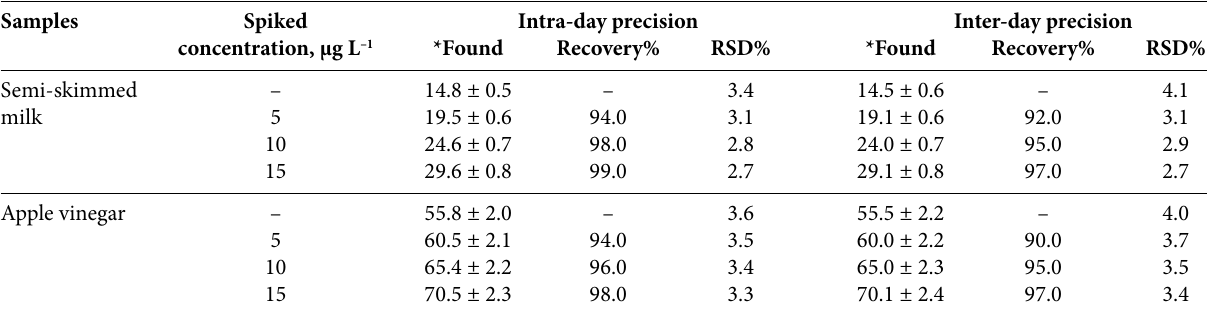
Table 3. (b) The reproducibility and repeatability for the replicate measurements of total V in quality control samples spiked with 5, 10 and 15 µg L –1 (n: 5)